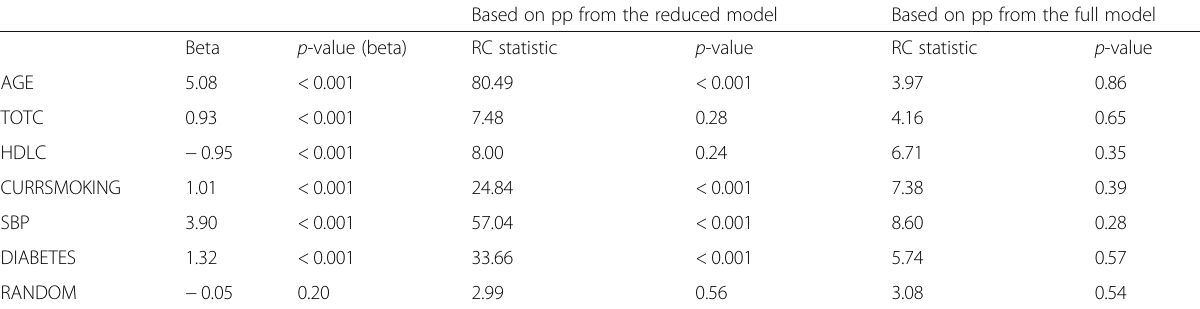
Table 5 Results of seven RC statistics tests, comparing the full model to one without the predictor in the first column of this table (reduced model) Based on pp from the reduced model Based on pp from the full